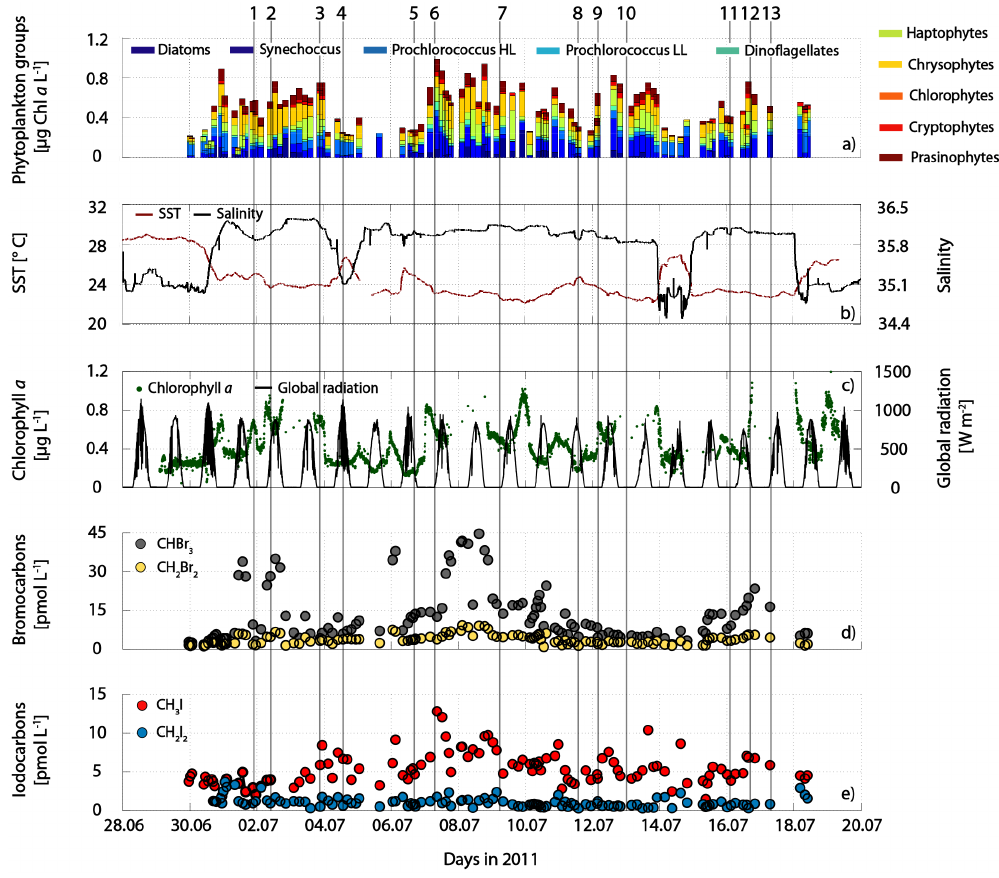
Figure 2. (a) Species composition (HL – high light, LL – low light), (b) SST and salinity during the cruise, (c) T Chl a from underway fluorescence sensor measurements and global radiation, (e) CHBr 3 and CH 2 Br 2 in surface sea water, and (e) CH 3 I and CH 2 I 2 surface sea water concentrations. The top numbers mark the CTD